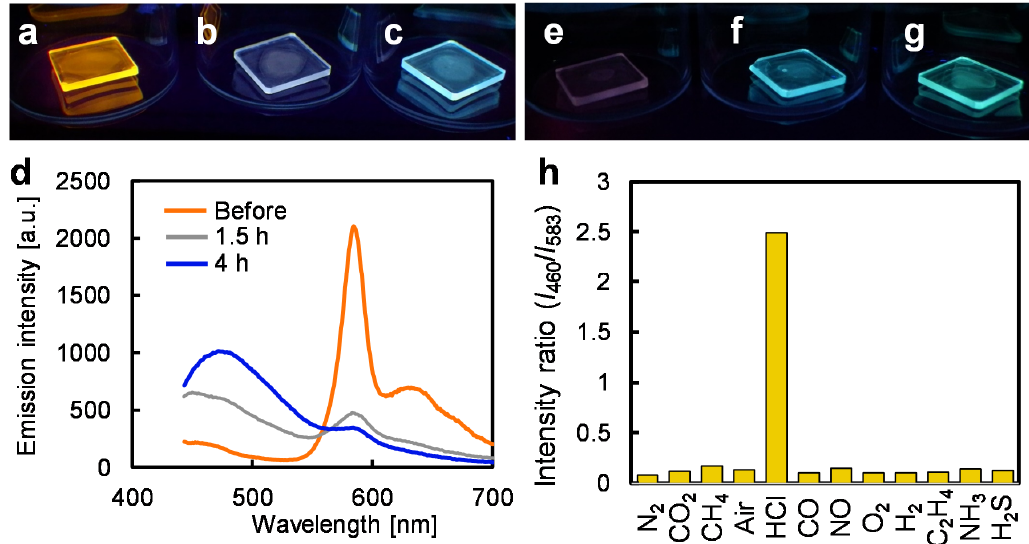
Figure 3. Depolymerizing experiments in the solid state: Emission photographs under deoxygenated conditions (excitation at 365 nm) of polymer 1 films on SiO 2 substrates ( a ) before reaction, and after reaction with HCl gas for ( b ) 1.5 h, and ( c ) 4 h. ( d ) Emission spectra of polymer 1 film in ( a – c ).